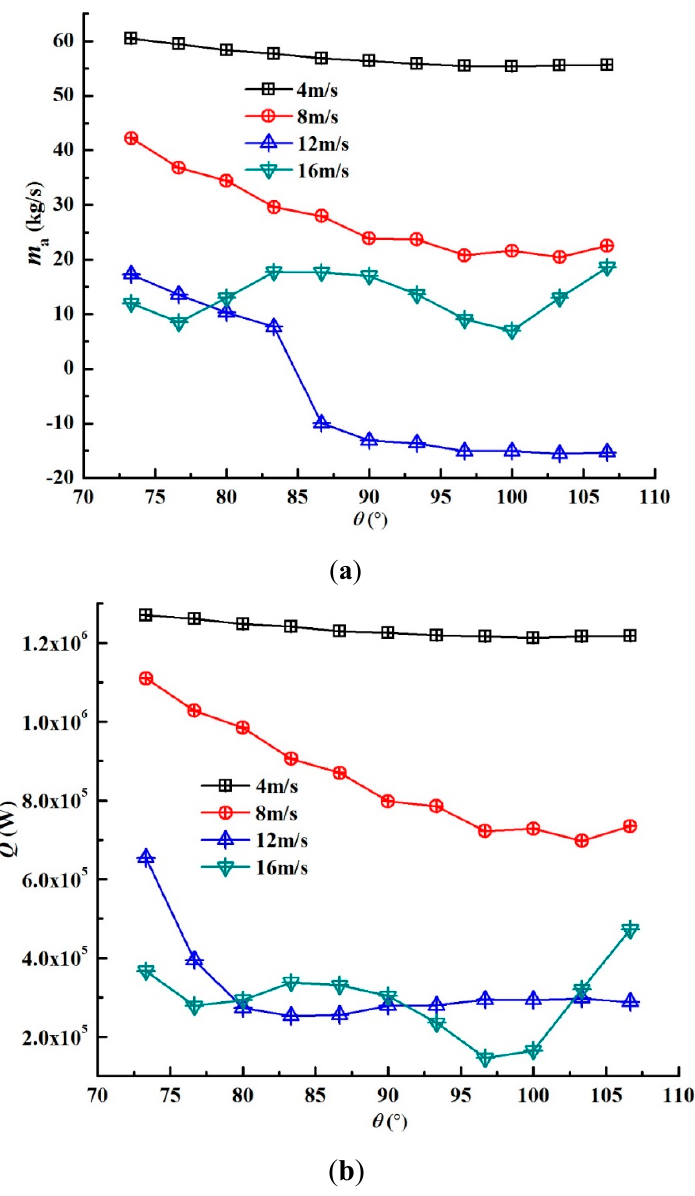
Figure 13. Thermo-flow performances of the middle deltas. ( a ) Air mass flow rate, ( b ) heat rejection.